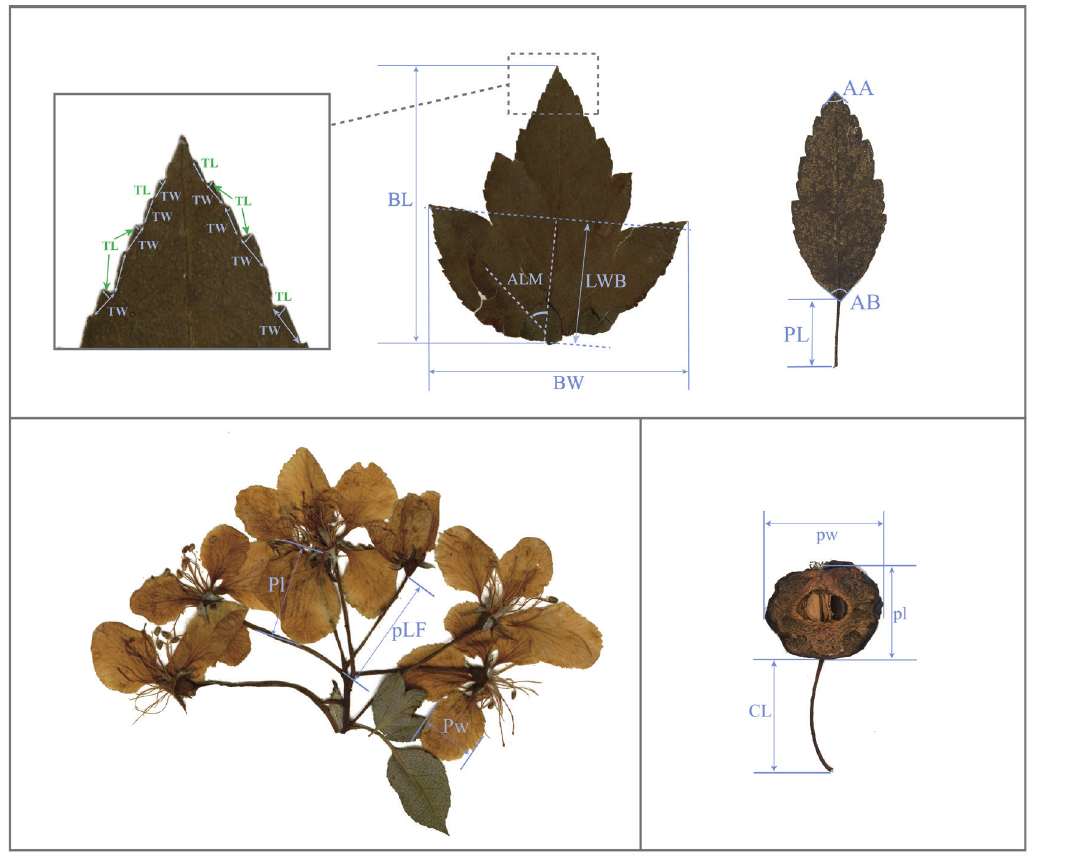
Fig. 1. Schematic for definition of morphological parameters for species of Malus Mill. (material from NYBG02812600, A00026590, and